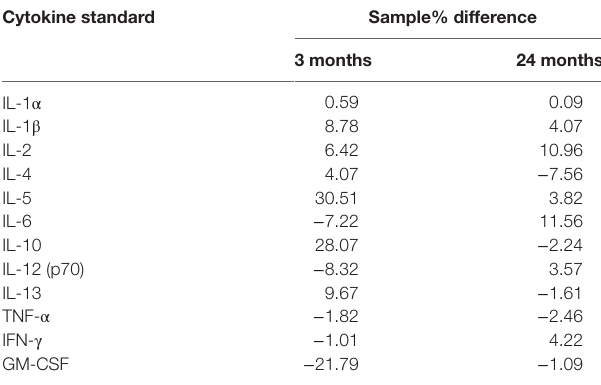
TaBle 1 | slope differences (% difference) of 3- and 24-month homogenate samples compared with standard